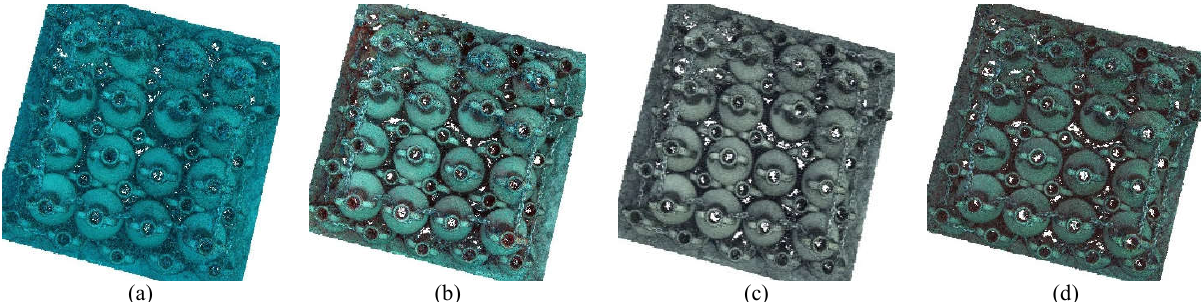
Figure 8. Medium quality point cloud for deep waters dataset from the original imagery (a), the imagery corrected with Adobe Photoshop (b), the imagery corrected by the algorithm of Bianco et al., (2015) (c) and the imagery corrected by the CLAHE